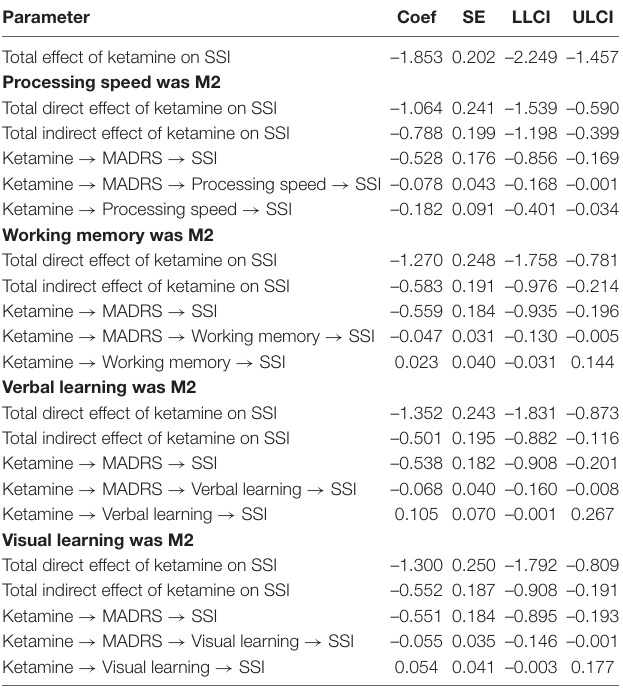
TABLE 2 | Mediation effects of depressive symptom and cognition on changes in suicidal ideation across